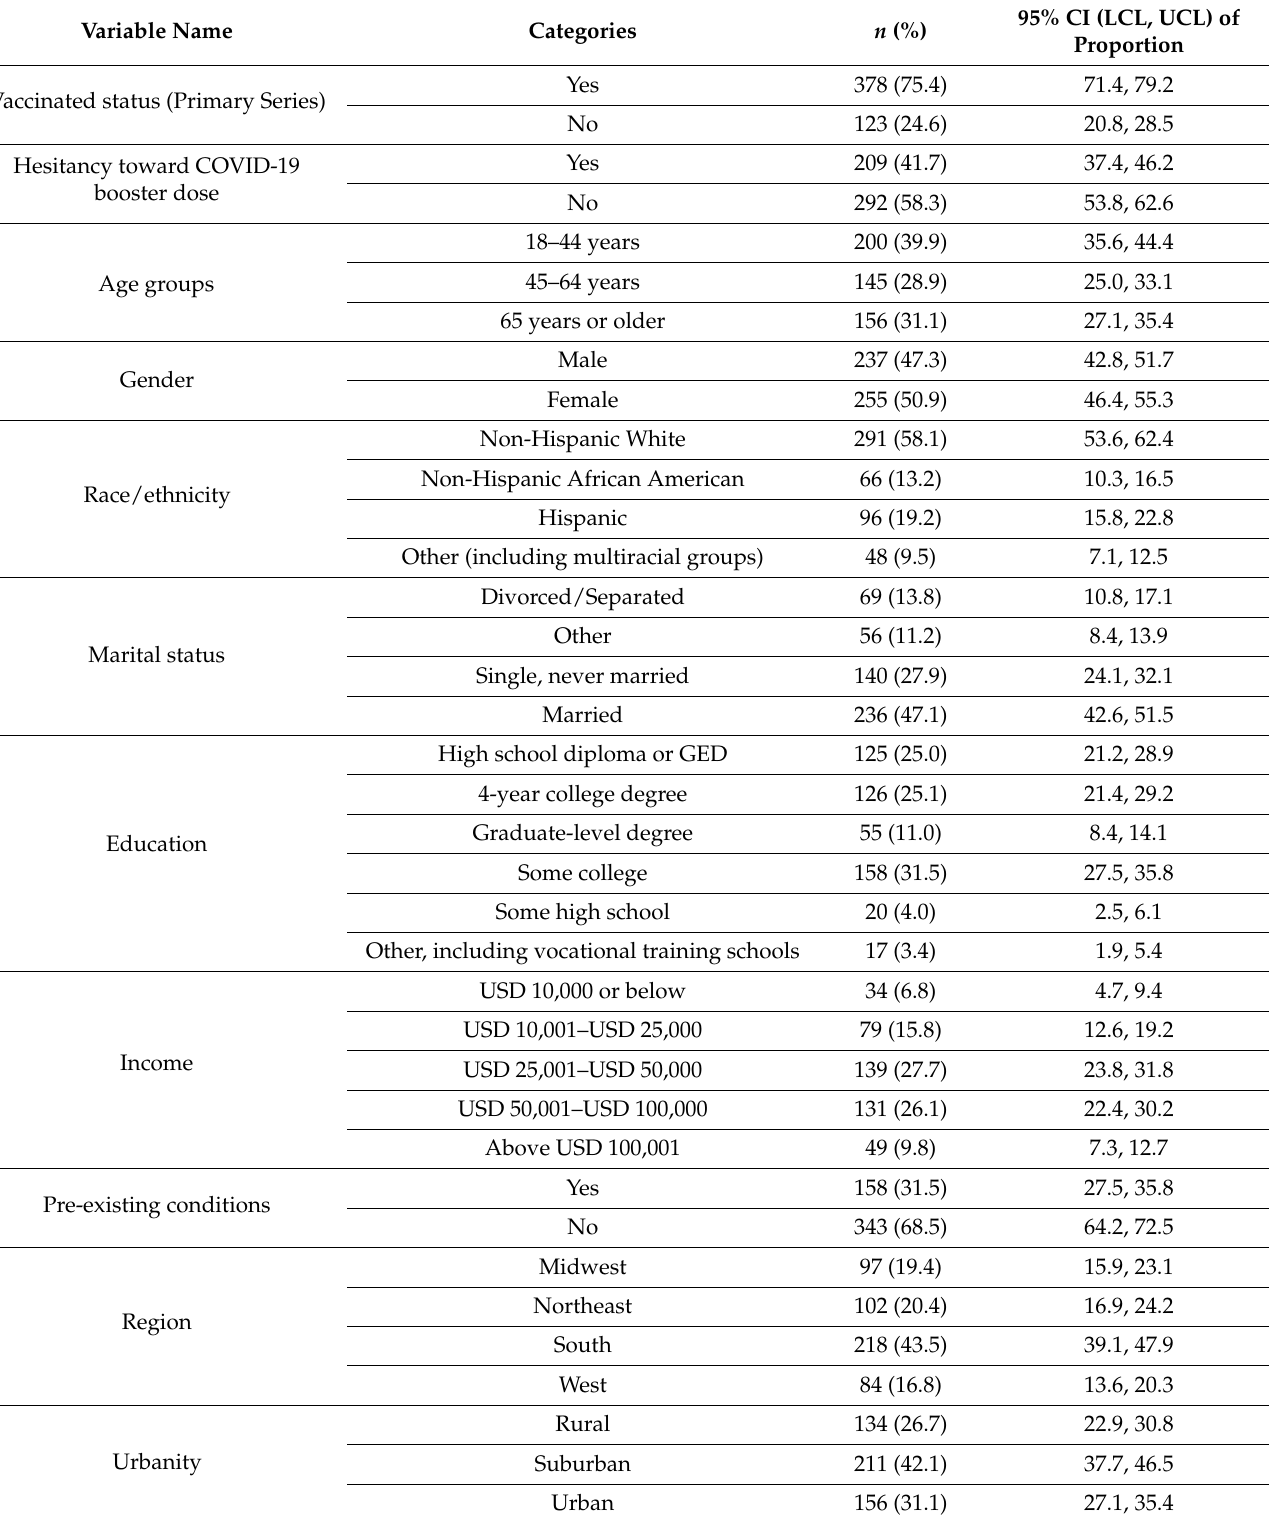
Table 1. Demographic characteristics of the respondents ( N =